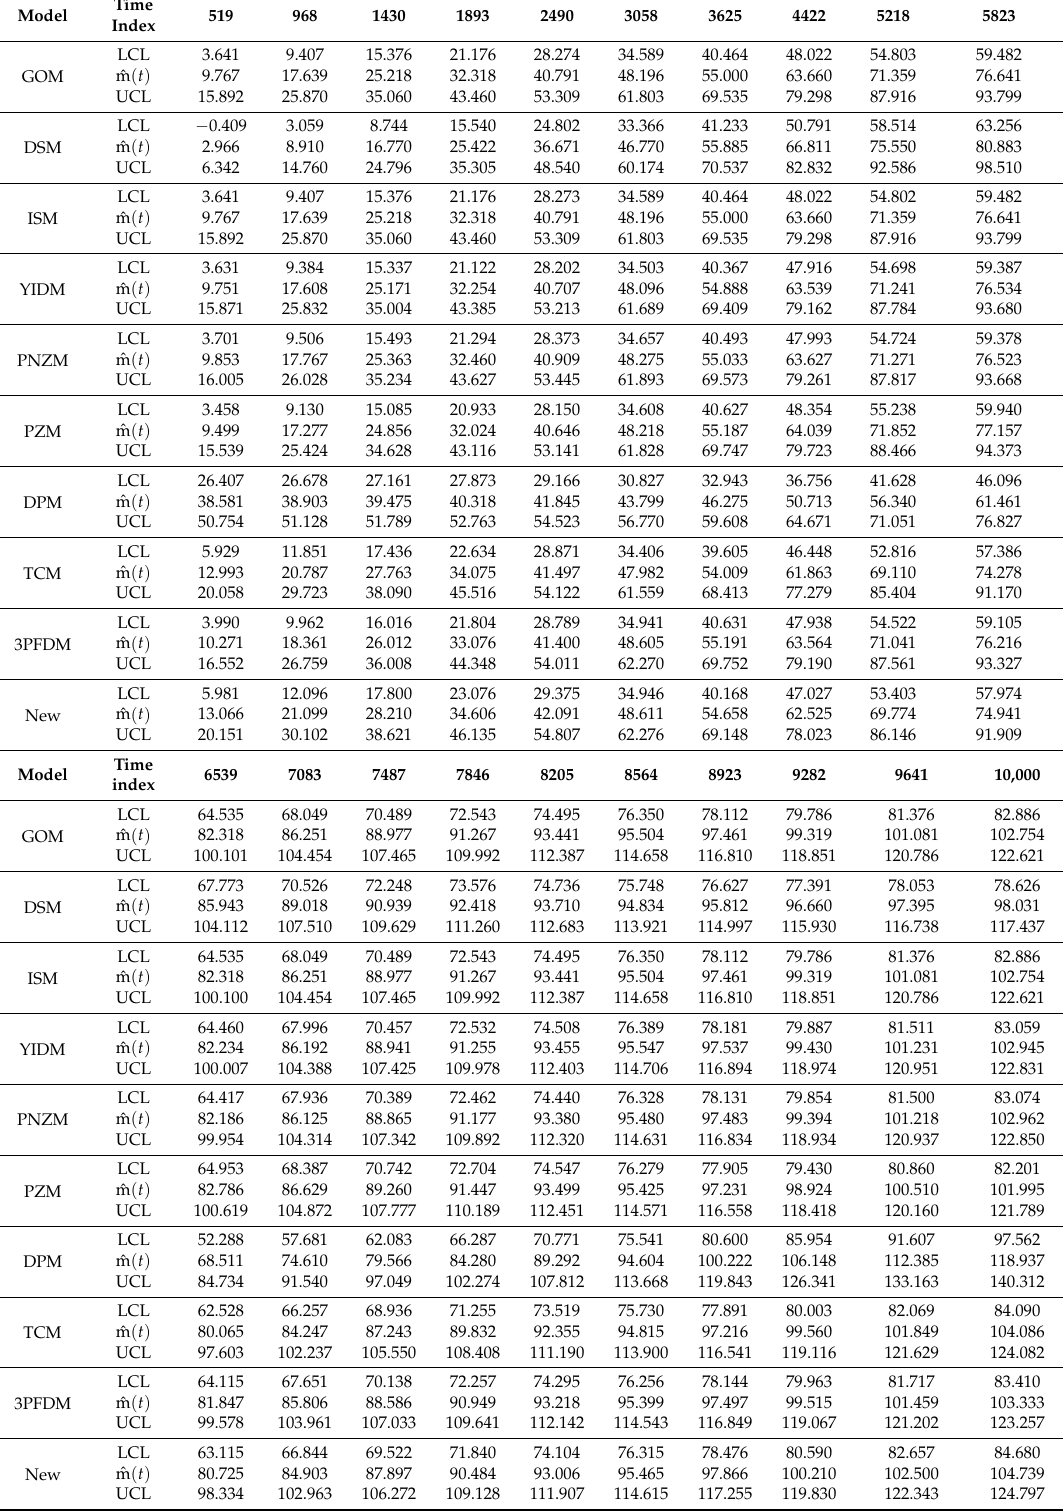
Table A3. 95% Confidence interval of all 10 models